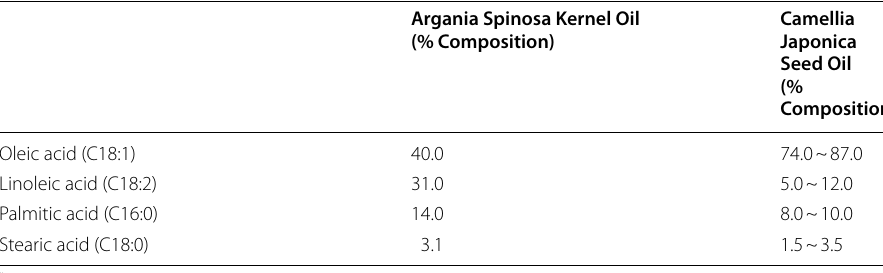
* Data provided by the suppliers of Argan oil and Camellia oil used in this